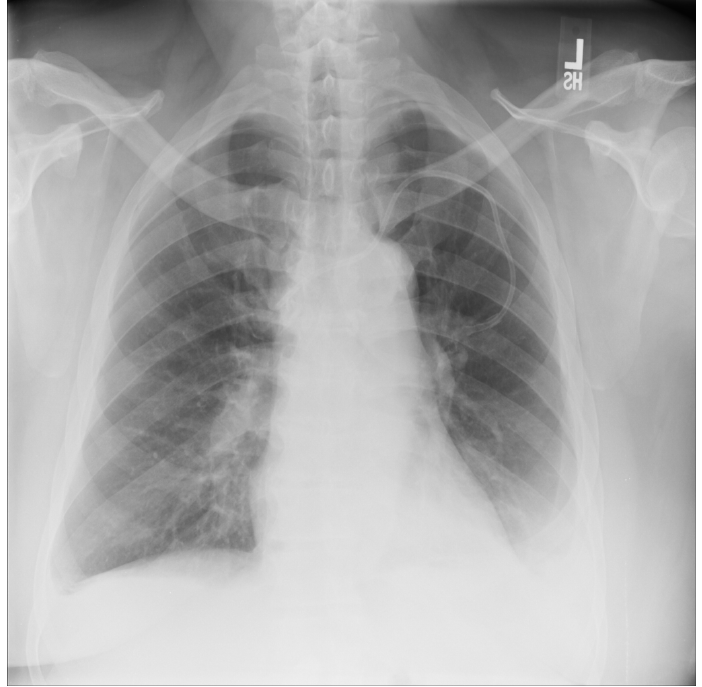
Figure 3. Original